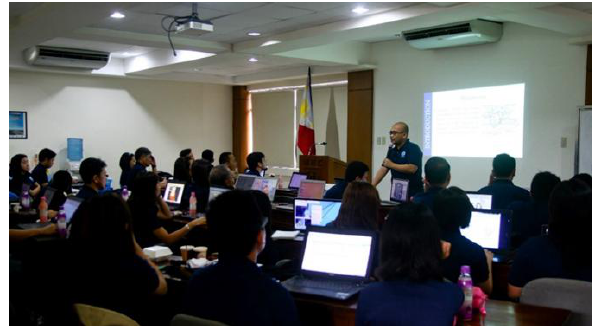
Figure 5. Field Data and Image Processing Lecture at the National Engineering Center, UP Diliman